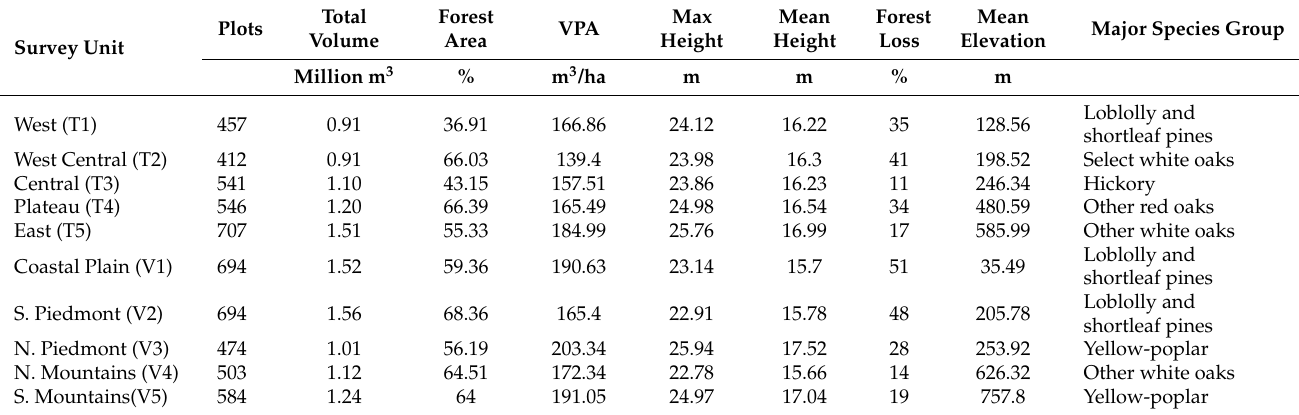
Table 1. FIA measurement summary.